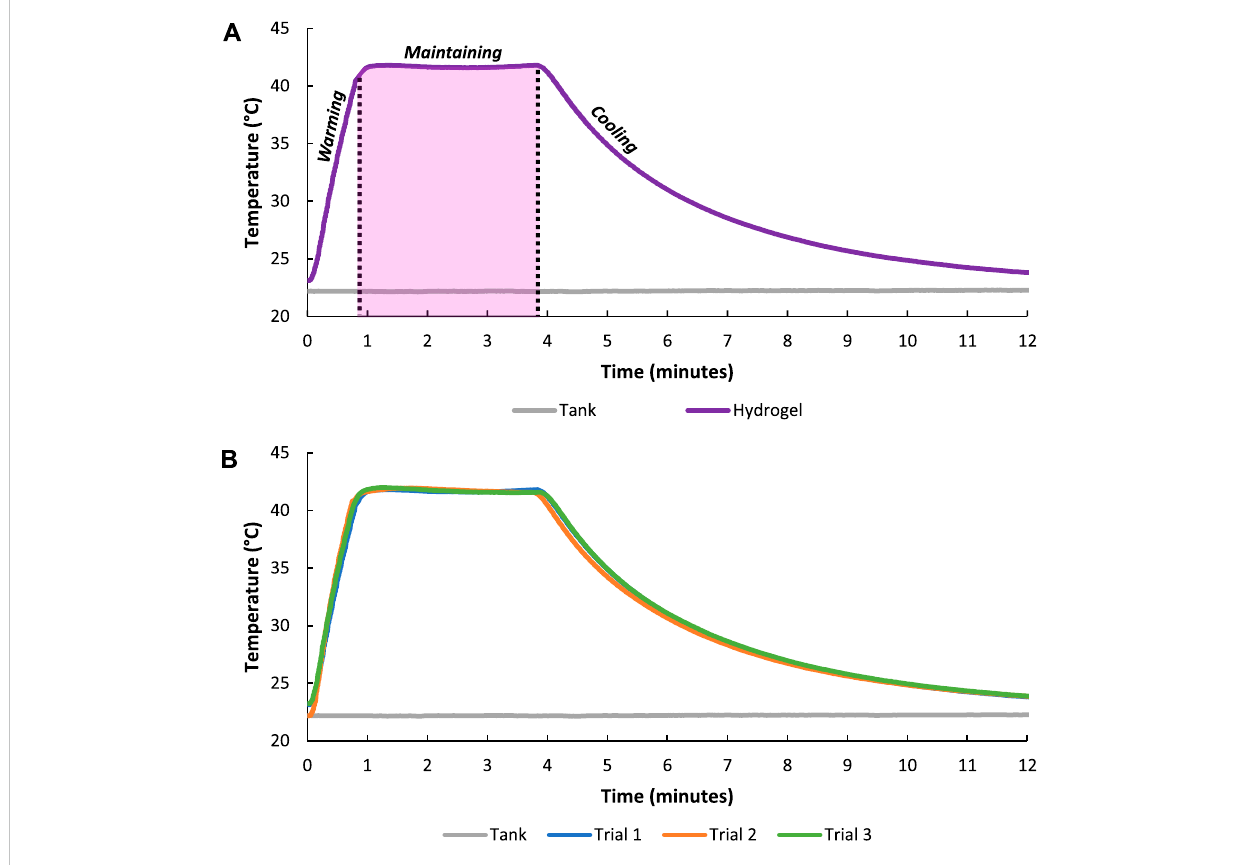
FIGURE 5 Temperature of the composite hydrogel during FUS warming (±5.8 MPa) to about 42 ° C, FUS treatment to maintain (±3 MPa) 42 ° C for 3 min, and cooling with FUS system turned off (0 MPa) (A) . FUS heating of composite hydrogel over three trials showing the repeatability of the treatment scheme (B)